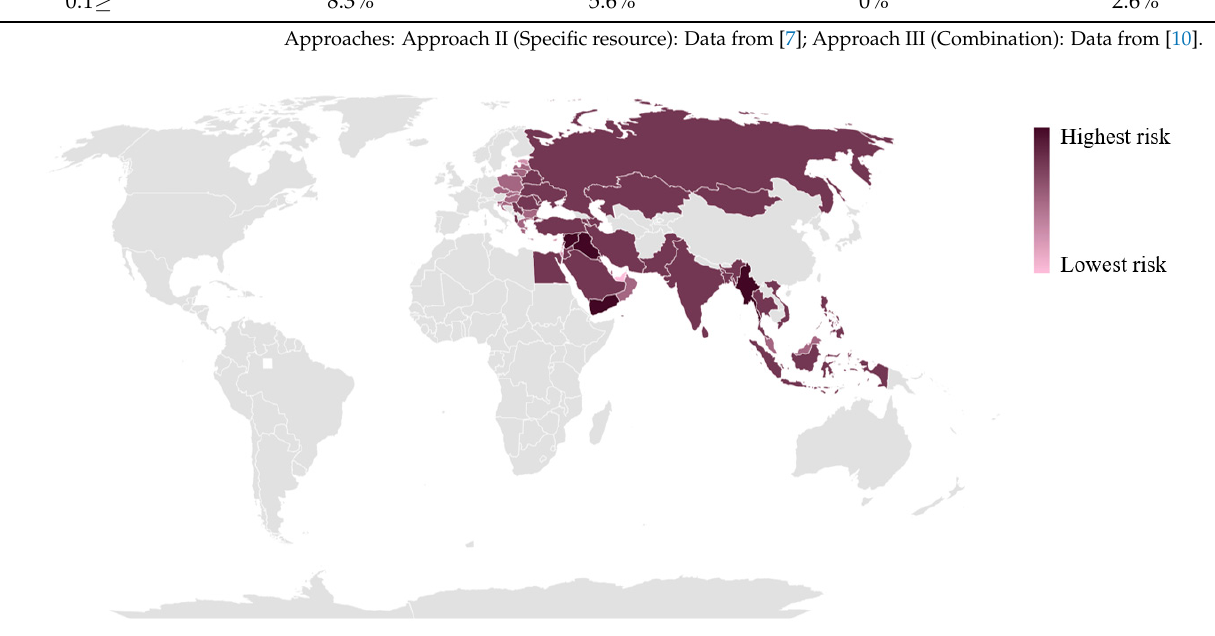
Figure 4. The results of the national investment risk evaluation based on 3-D evaluation.